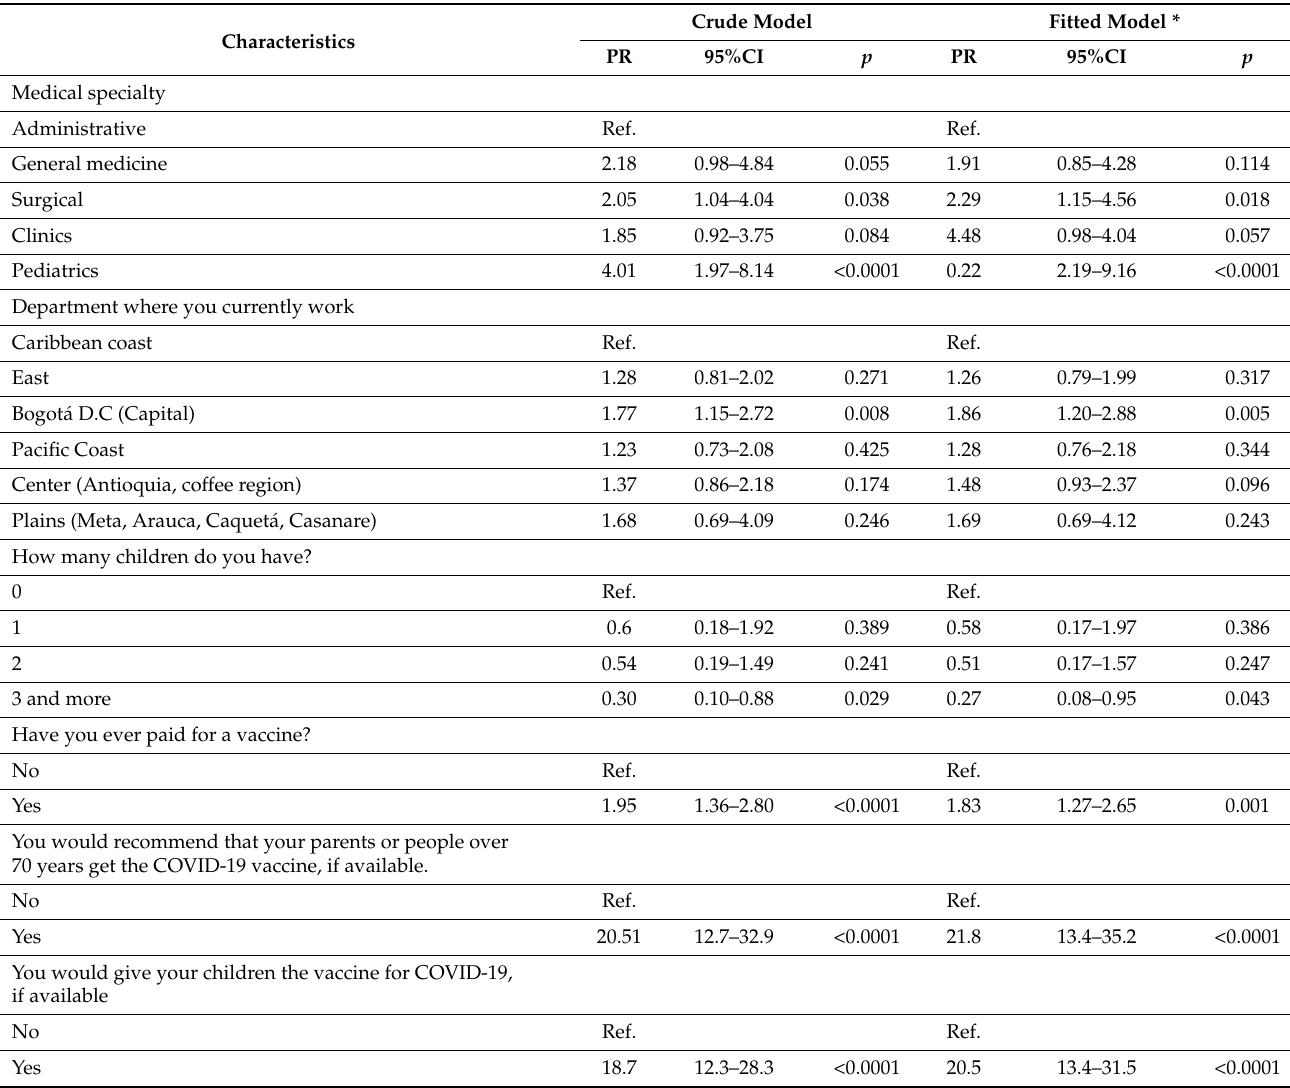
Table 2. Variables associated with the acceptance of free vaccination with an effectiveness of 60%.